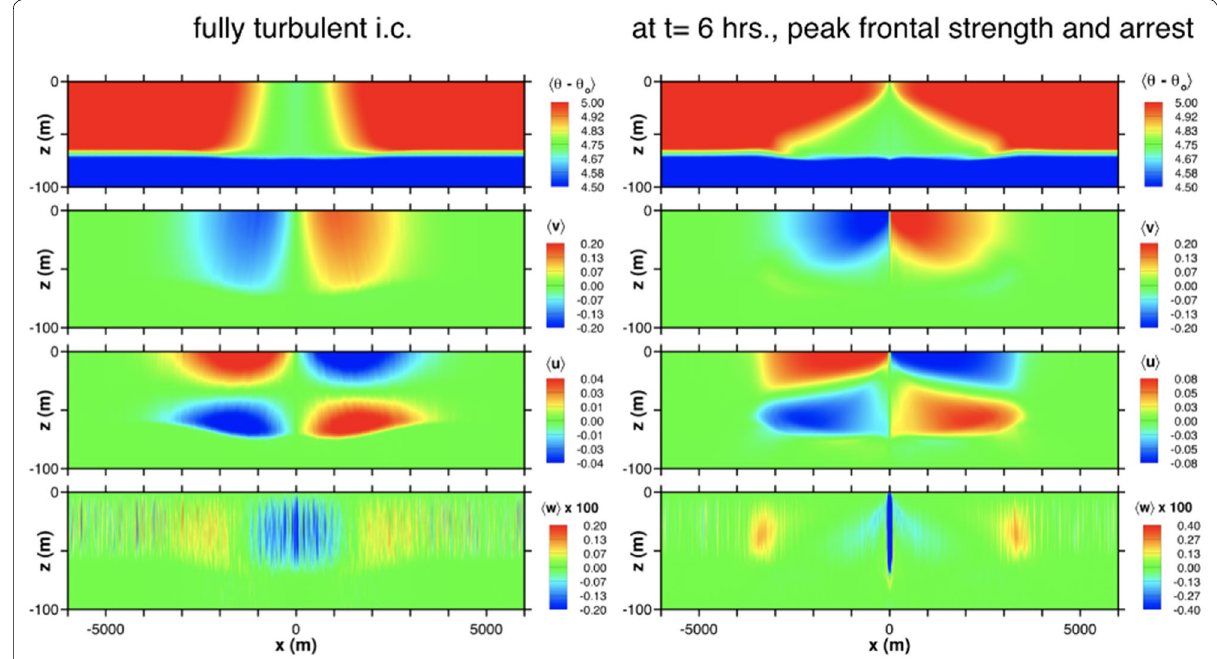
Fig. 9 Simulated filament frontogenesis by TTW. A fully turbulent “initial condition” (left) and 6 h later at the time of peak frontal strength and frontal arrest (right), in a Large-Eddy Simulation (LES) of a submesoscale dense filament in a boundary layer with surface cooling (Sullivan and McWilliams 2018). The ( x , z ) fields are averaged in the along-front y direction: temperature � θ � − θ 0 , along-front velocity (cid:31) v (cid:30) , cross-front velocity (cid:31) u (cid:30) , and vertical velocity (cid:31) w (cid:30) . Units are ◦ C and m s − 1 , respectively. The apparent noise in (cid:31) w (cid:30) is sampling error due to the finite domain size in y and the presence of much larger w values in the turbulent